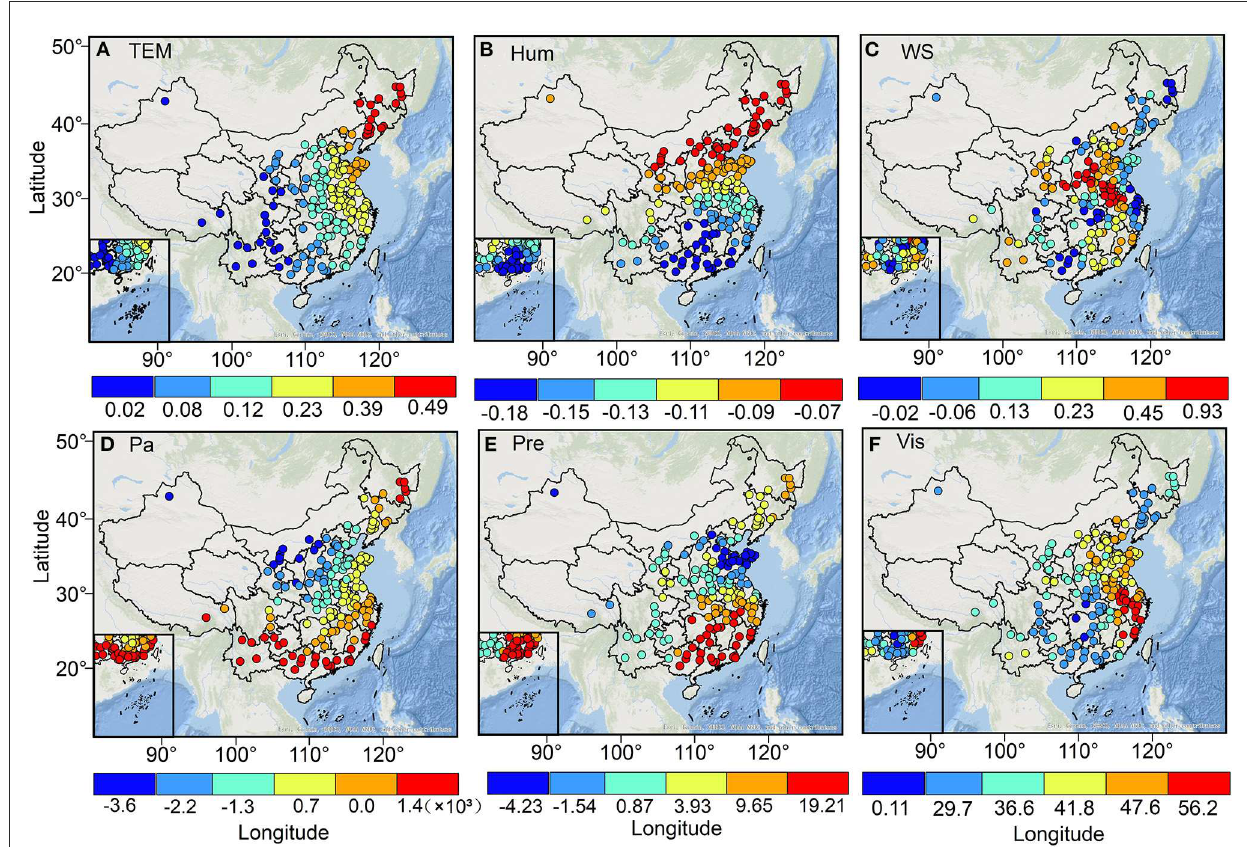
FIGURE10 The spatial distribution of regression coefficients for the major meteorological factors of TEM (A) , Hum (B) , WS (C) , Pa (D) , Pre (E) , and Vis (F)